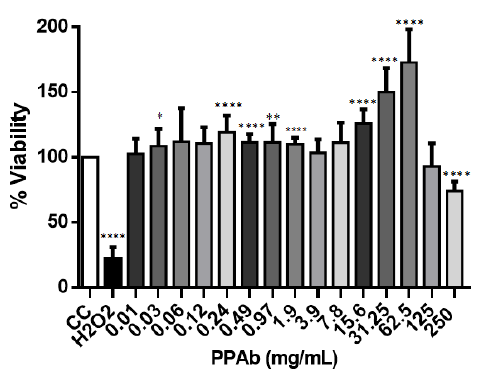
Figure 5. Cytotoxicity of the PPAb for human intestinal C2BBe1 cells. Polarized C2BBe1 cells were exposed to different concentrations of the PPAb at 37 °C and 5% CO 2 for 24 h. Cell viability was assessed by MTT assay. CC: cell control (non- PPAb treated cells); H 2 O 2 : cytotoxicity control. Bars represent mean ± SD. * p <0.05, ** p <0.01, **** p <0.0001; unpaired Welch’s t -test for comparisons with the CC control.